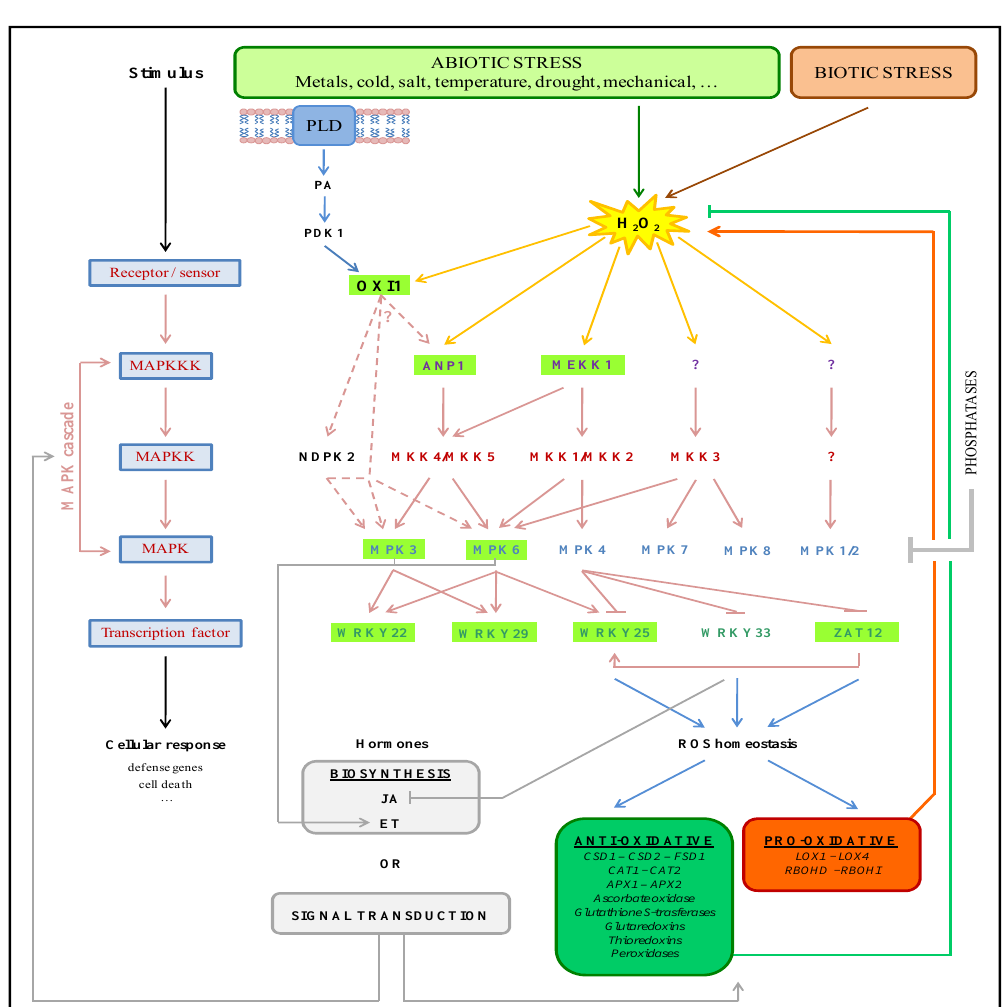
O can act as an 2 2